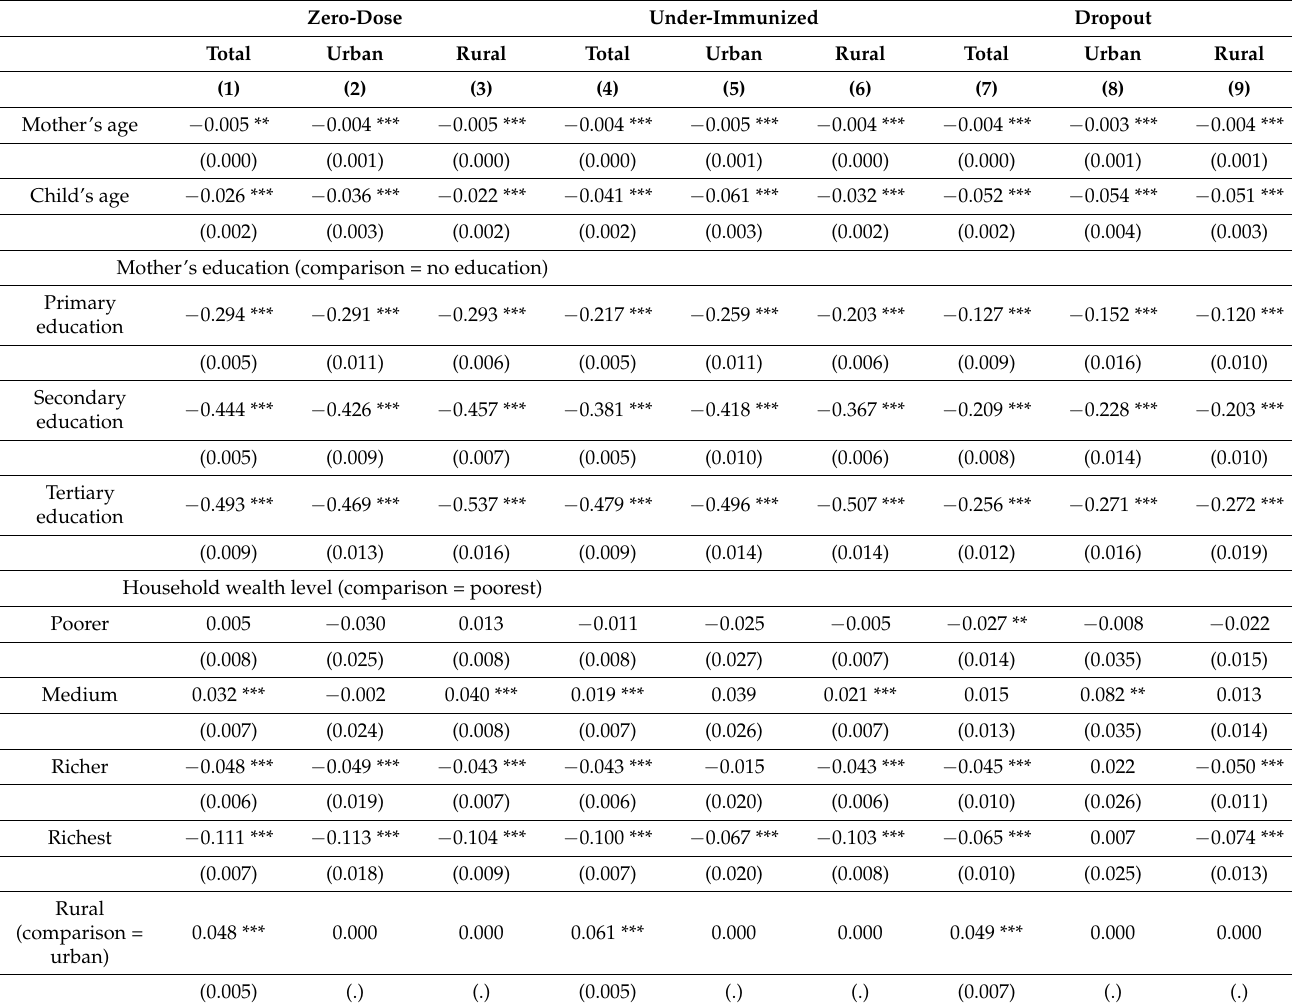
Table 1. Correlation between the likelihood of children having incomplete vaccination status and sociodemographic factors.